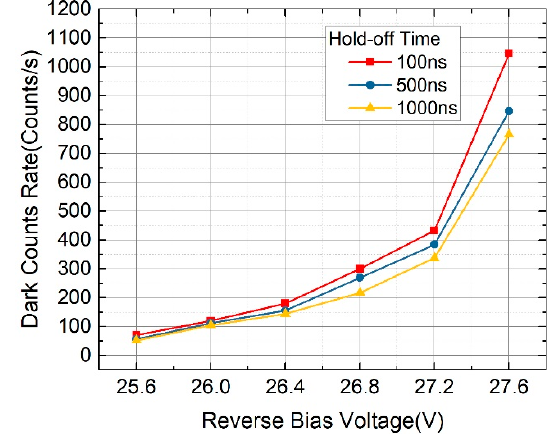
Figure 7. Dark count rate measured for varies bias voltages.